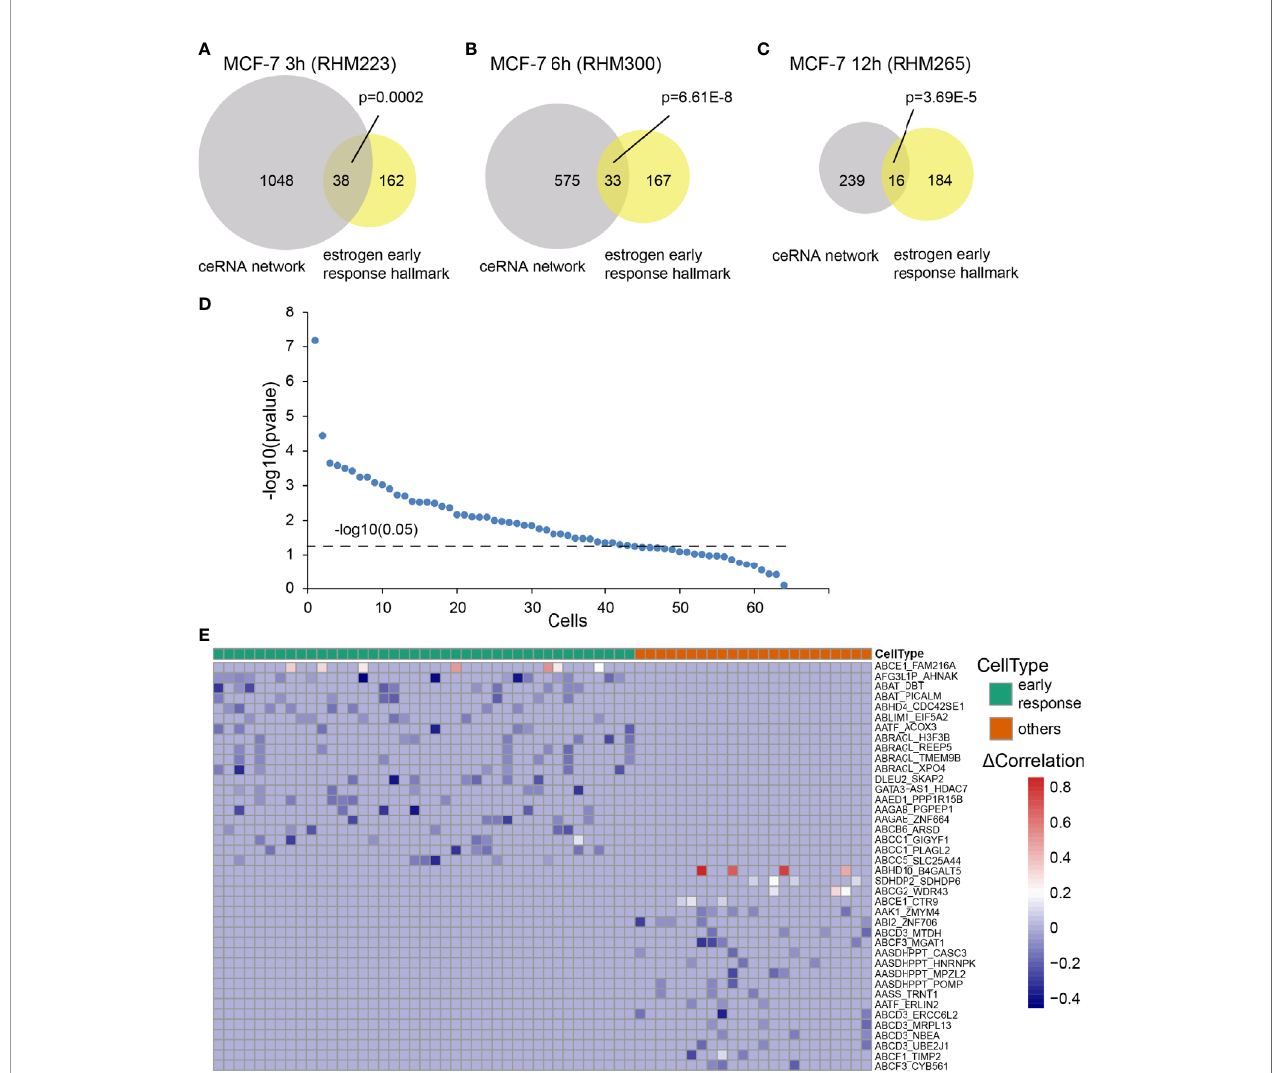
FIGURE 3 | Cell subtypes inferred by the CCN. The RNAs in the CCN were enriched into estrogen early response hallmark, as determined by a hypergeometric test. We showed signi fi cant enrichment of RNAs in the CCN of the (A) MCF-7 3 h (RHM223), (B) MCF-7 6 h (RHM300), and (C) MCF-7 12 h (RHM265) cells to the early response hallmarks. (D) The minus log10 transformed p-value calculated by a hypergeometirc test for all cells at 3, 6, and 12 h. The dashed line represents the signi fi cance threshold, p = 0.05. (E) The heatmap of differential correlation ( D Correlation ) in all cells that were classi fi ed into two subtypes: early response cells vs. others. Blue represents loss of correlation in the “ Perturbed network ” , while red refers to the gain of correlation in the “ Perturbed network ”